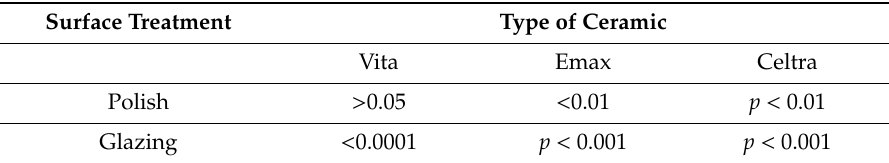
Table 6. One-way ANOVA statistical analysis based on surface treatments polished and glazed before and after thermocycling for Rz parameter.